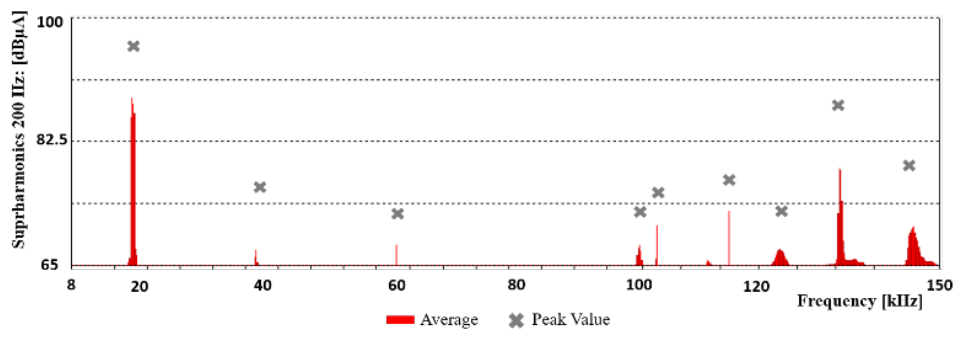
Figure 11. Supraharmonic emissions from 9–150 kHz according to IEC61000-4-7 with increased frequency range [14].